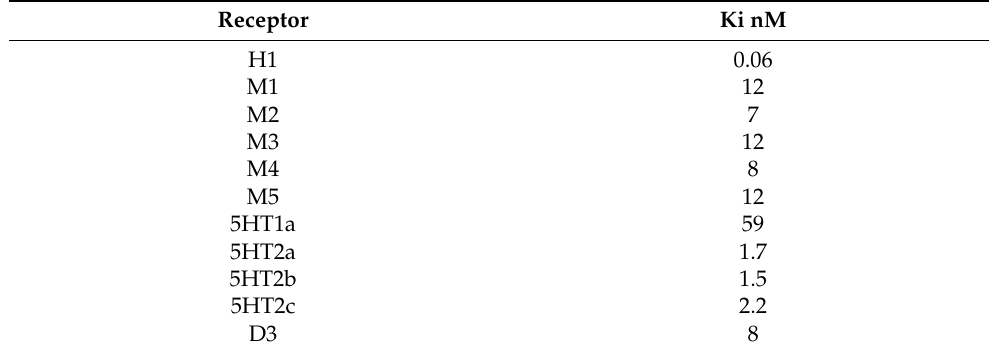
Table 2. Inhibitory binding of cyproheptadine at histaminic (H), muscarinic (M), serotonergic (5HT), and dopamine (D)